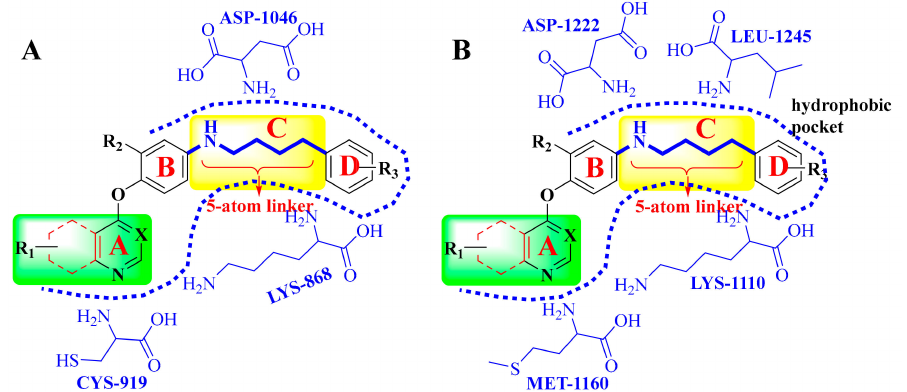
Figure 15. ( A ) The model of dual-target VEGFR / c-Met inhibitors bound to VEGFR. ( B ) The model of dual-target VEGFR / c-Met inhibitors bound to